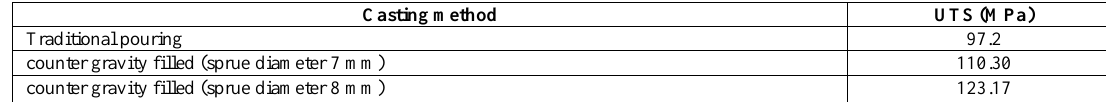
Table 1. Ultimate tensile strength of cast samples